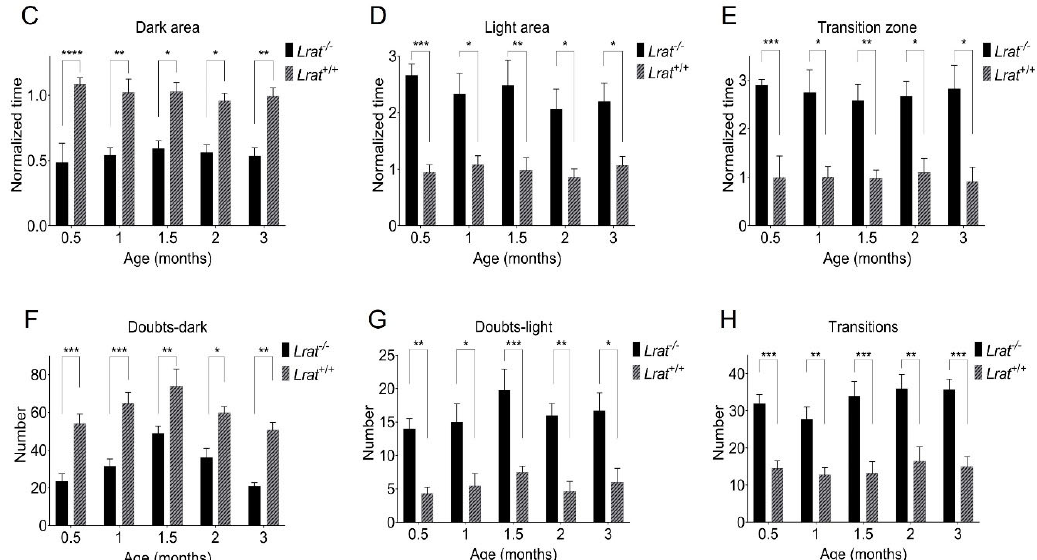
Figure 9. Light/dark box vision-based behavioral responses of Lrat +/+ ( n = 6), Lrat +/ − ( n = 5) and Lrat − / − ( n = 6) animals. A schematic overview of the customized light/dark box used is presented in panel ( A ). No significant differences between Lrat +/ − and Lrat +/+ animals were observed for the time spent in any area at the age of 23 weeks ( B ). Lrat − / − spend more time in the dark area than the Lrat +/+ animals ( C , D ). Lrat − / − spend more time in the transition zone (the area around the door) and switch compartment more than Lrat +/+ animals ( E ). Lrat +/+ animals doubt more to enter the light compartment ( F ) and less to enter the dark compartment ( G ) than Lrat − / − animals. Lrat − / − switch areas more often than Lrat +/+ animals ( H ). Wildtype rats are more comfortable spending more time in a dark area. These data show that the knockout animals do not have the same preference, indicating that they cannot distinguish between the dark and light areas and are visually impaired. The data in panels ( B – E ) are normalized to the averaged Lrat +/+ behavior of all measurements for each parameter separately. The wildtype animals’ data were averaged for all measurements (all time points together) per parameter. This was possible since the behavior of the wildtype animals did not change significantly over time. These values were used for the normalization of the data of the Lrat − / − animals. ns = non ‐ significant; * = p < 0.05; ** = p < 0.01; *** = p < 0.001; **** = p ≤ 0.0001.